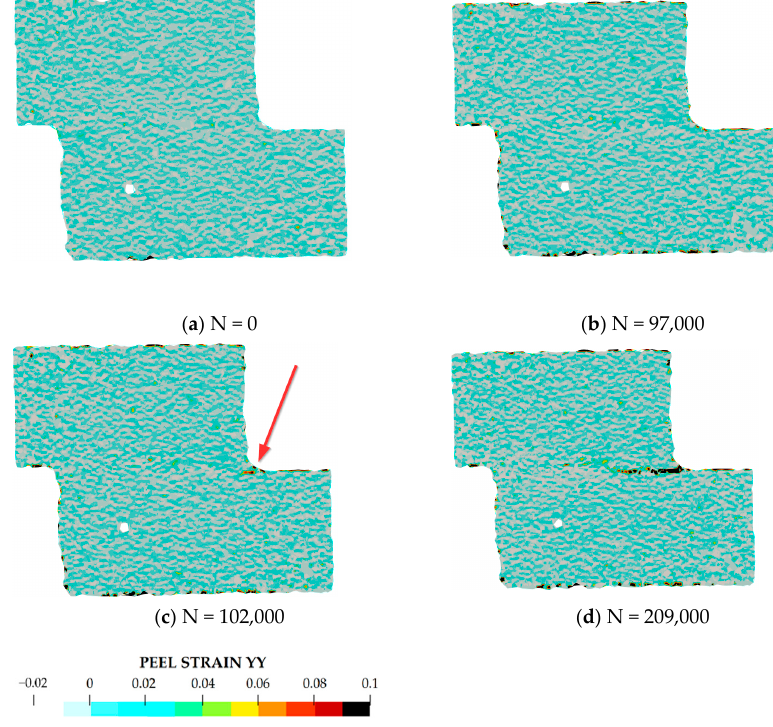
Figure 4. Example of peel strain values measured by digital image correlation during a test: ( a ) at the beginning of the test; ( b ) last acquisition before crack onset; ( c ) first acquisition after crack onset; ( d ) a few cycles before the final failure.